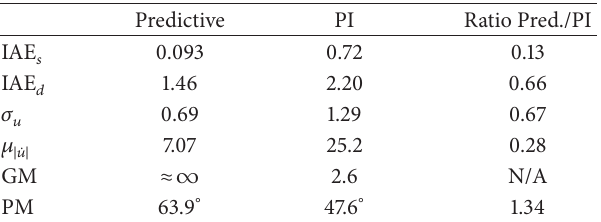
Table 3: Performance and robustness measures for predictive control and PI